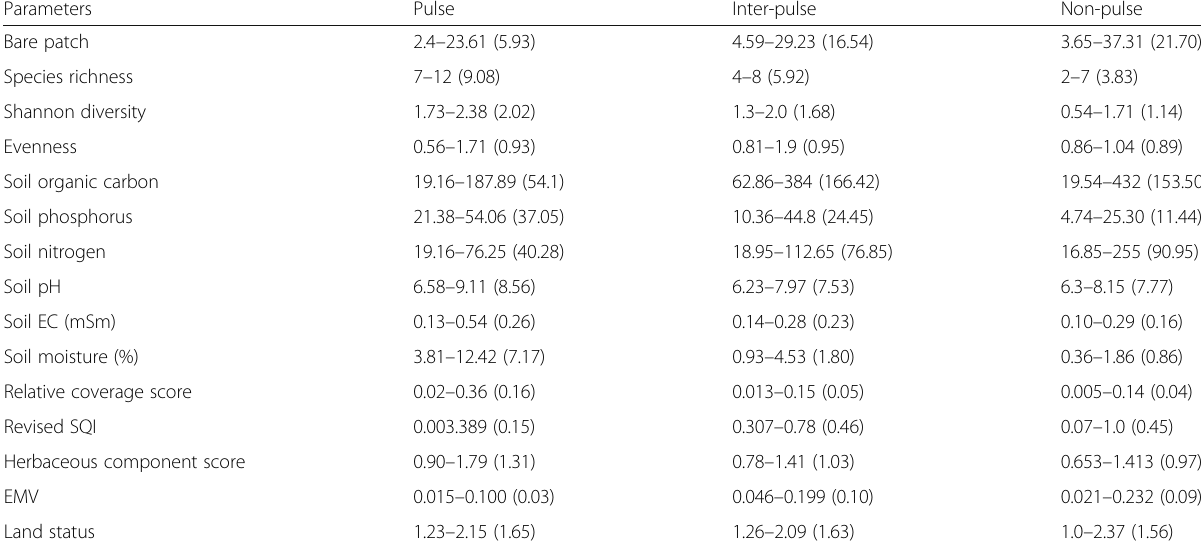
Table 3 Range of various communities, soil, and various assessment